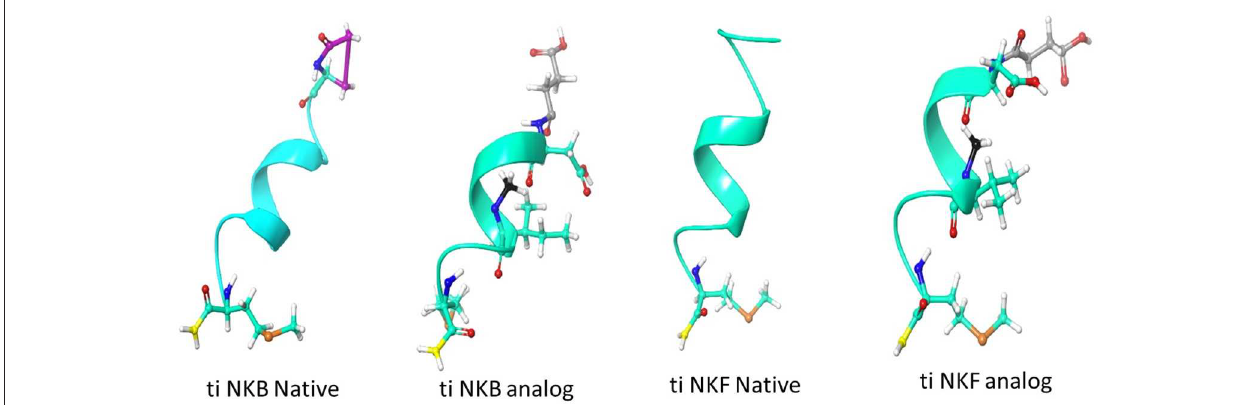
FIGURE 1 | Structural model of human and tilapia NKBs and their analogs represented as cartoon ribbons. The structural models were predicted using human NKB (PDBID 1p9f) as a template. The amino acid modifications were then added using draw feature in Schrodinger, the succinylation is shown in gray, N-methyl is shown in black, amidation is shown in yellow and pyroglutamination is shown in